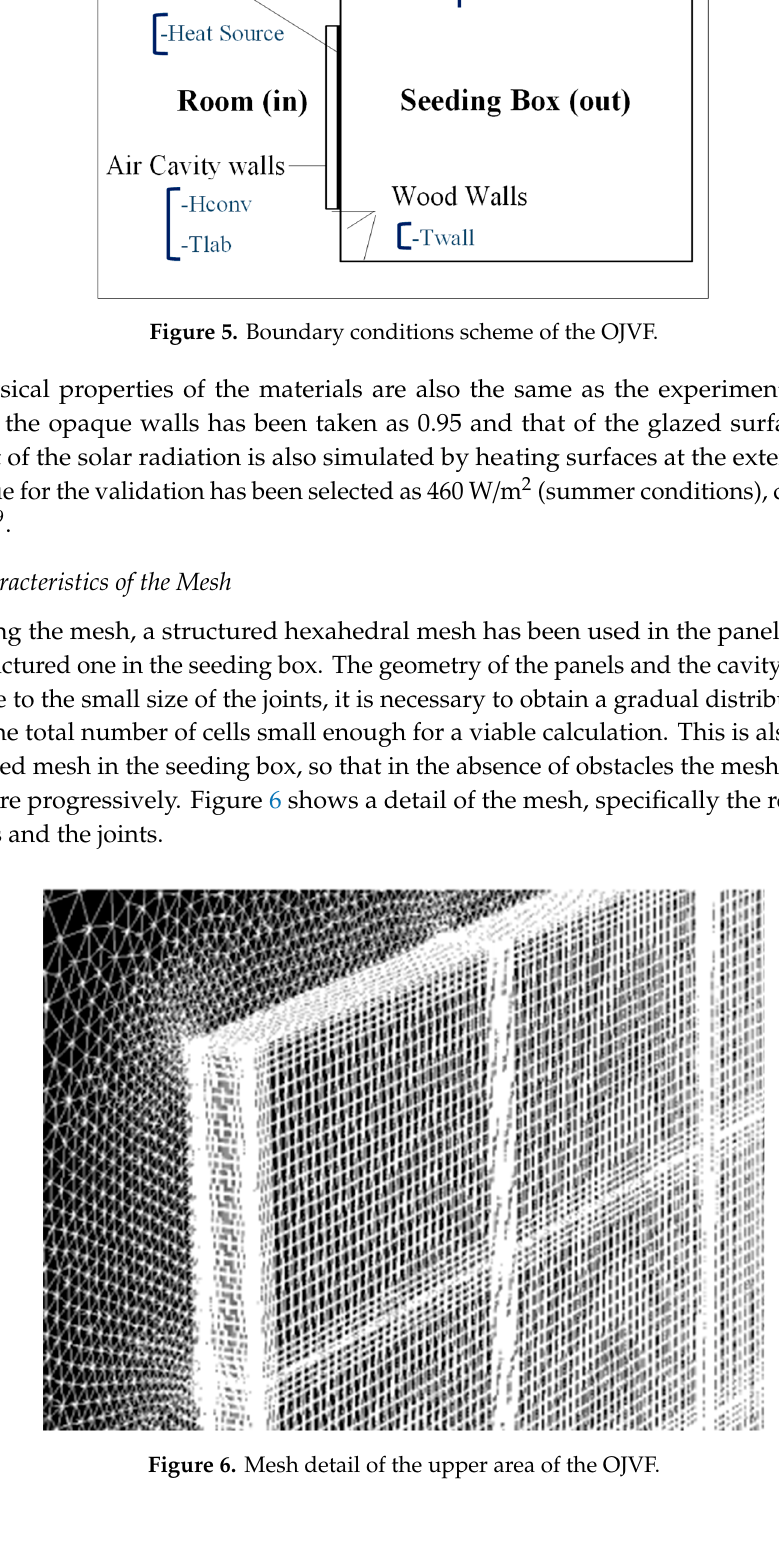
Table 2. Mesh discretization cases evaluated in the sensitivity analysis.